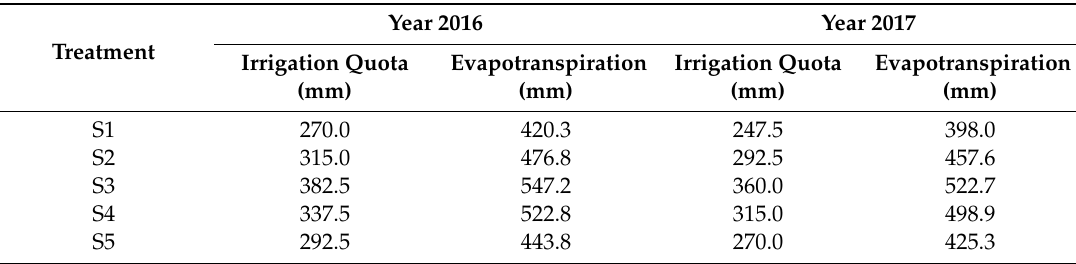
Table 6. Irrigation quota and